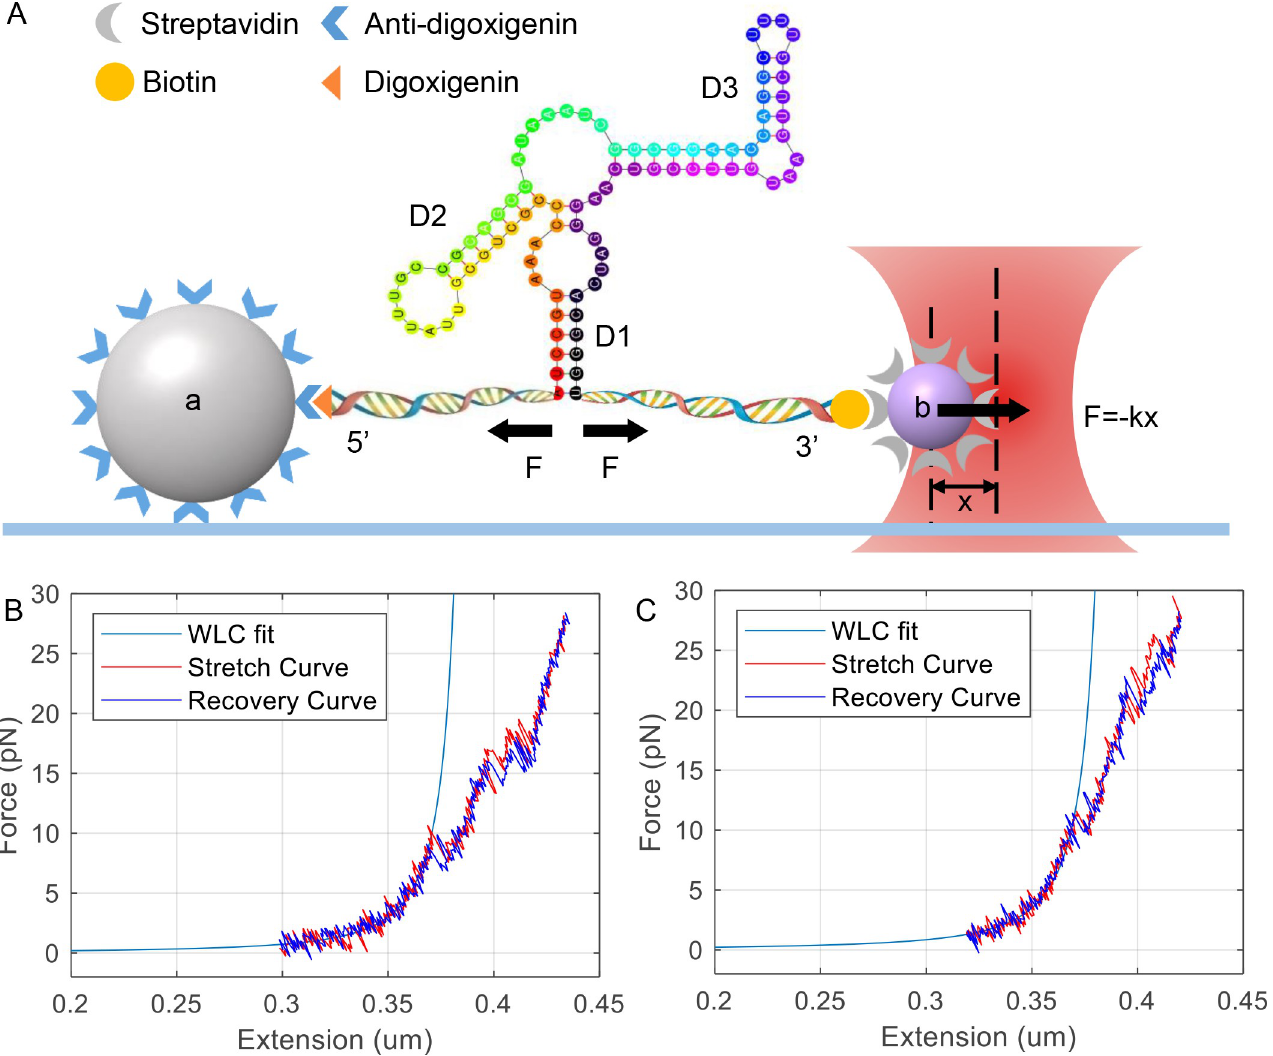
Fig 1. Schematic diagram of stretching rpoS inhibitory stem by optical tweezers and RNA force vs. extension curve (FEC). (A) 2 μ m anti-digoxigenin coated polystyrene bead (a) attached to cover glass (light blue line) covalently. An 1 μ m streptavidin coated polystyrene bead (b) was captured by optical tweezers. The two ends of the 87-nt three-way junction (colored dot line) located between two DNA/RNA hybrid handles, that linked to a and b via digoxigenin and biotin modification. D1, D2 and D3 are three helical regions of 3-way junction. Black arrows indicate force direction. X is the distance between bead b and the center of optical tweezers. F = -Kx is the force applied on b via optical tweezers. k is stiffness of optical tweezers. (B) rpoS mRNA inhibitory loop unfolding (red line) /refolding (violet line) FECs without Mg 2+ . (C) unfolding/refolding FECs of same RNA in (B) but with extra 10mM MgCl 2 . The unit of X-axis is μ m and of Y- axis is pN. The smooth blue curves are the fitting curves of worm-like chain model. Experimental data was acquired under a speed of 100k Hz and filtered to 100 Hz before recording.